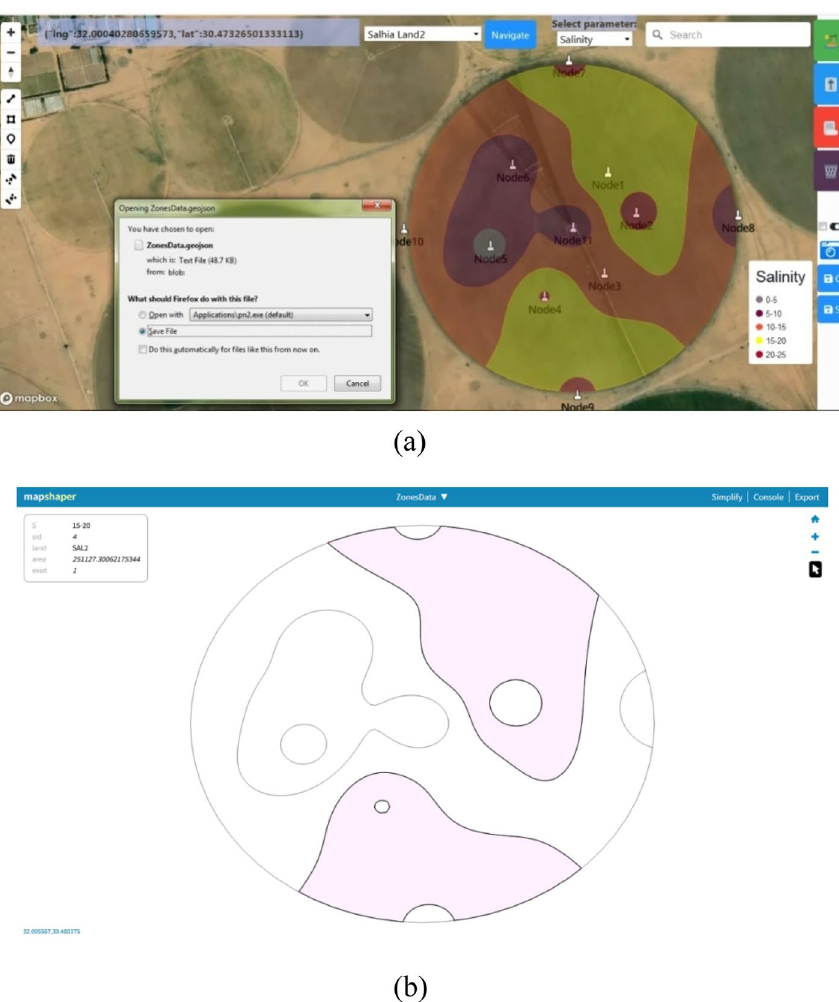
Figure 21. Exporting the MZ map as GeoJSON and Shapefile, ( a ) save map, ( b ) open the saved map using Mapshaper.